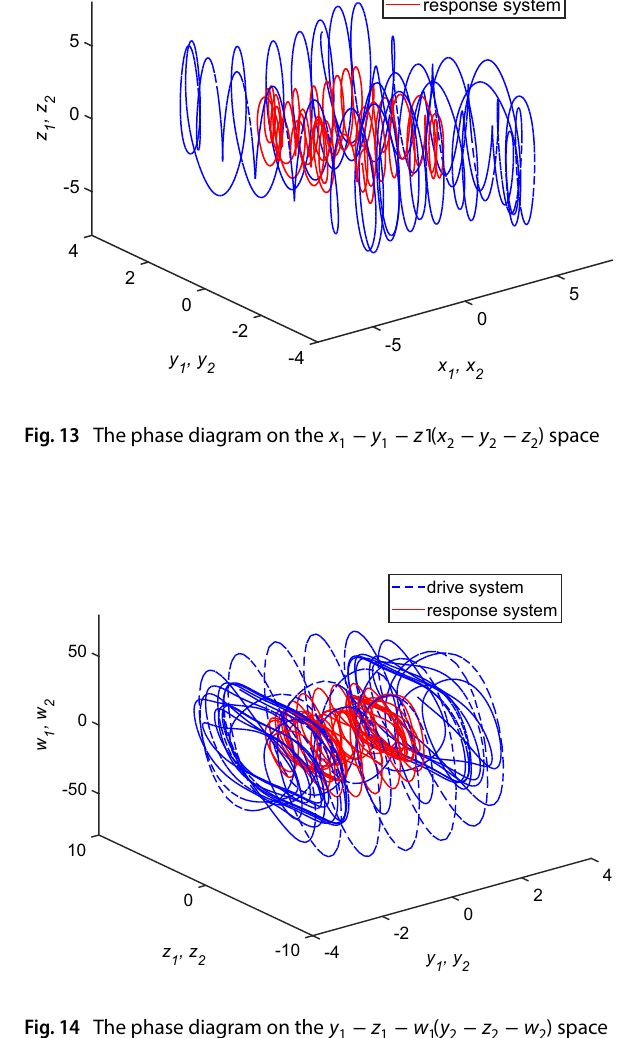
Fig. 12 The enlargement of the control u